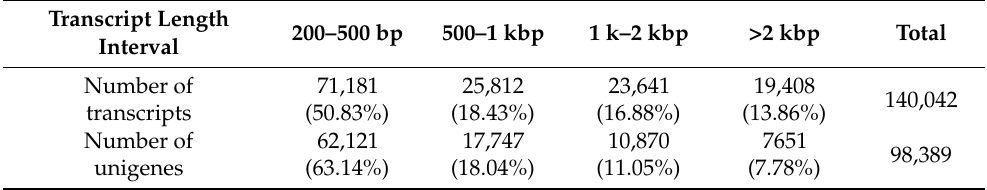
Table 1. Length distribution after assembly in the flower transcriptome of L. yunnanensis .